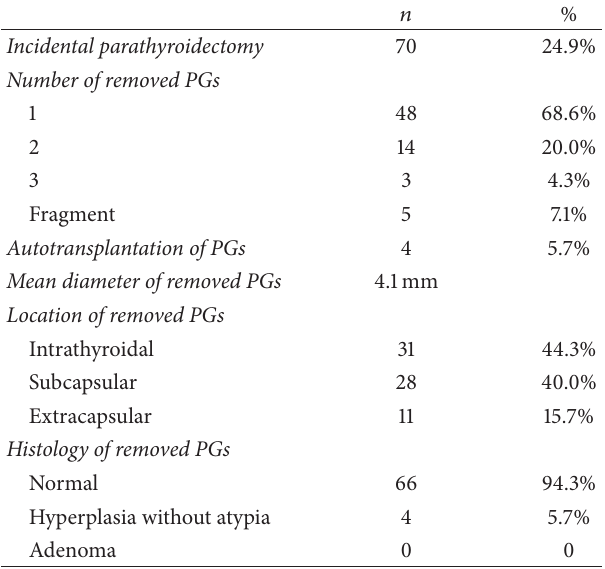
Table 2: Incidental parathyroidectomy.